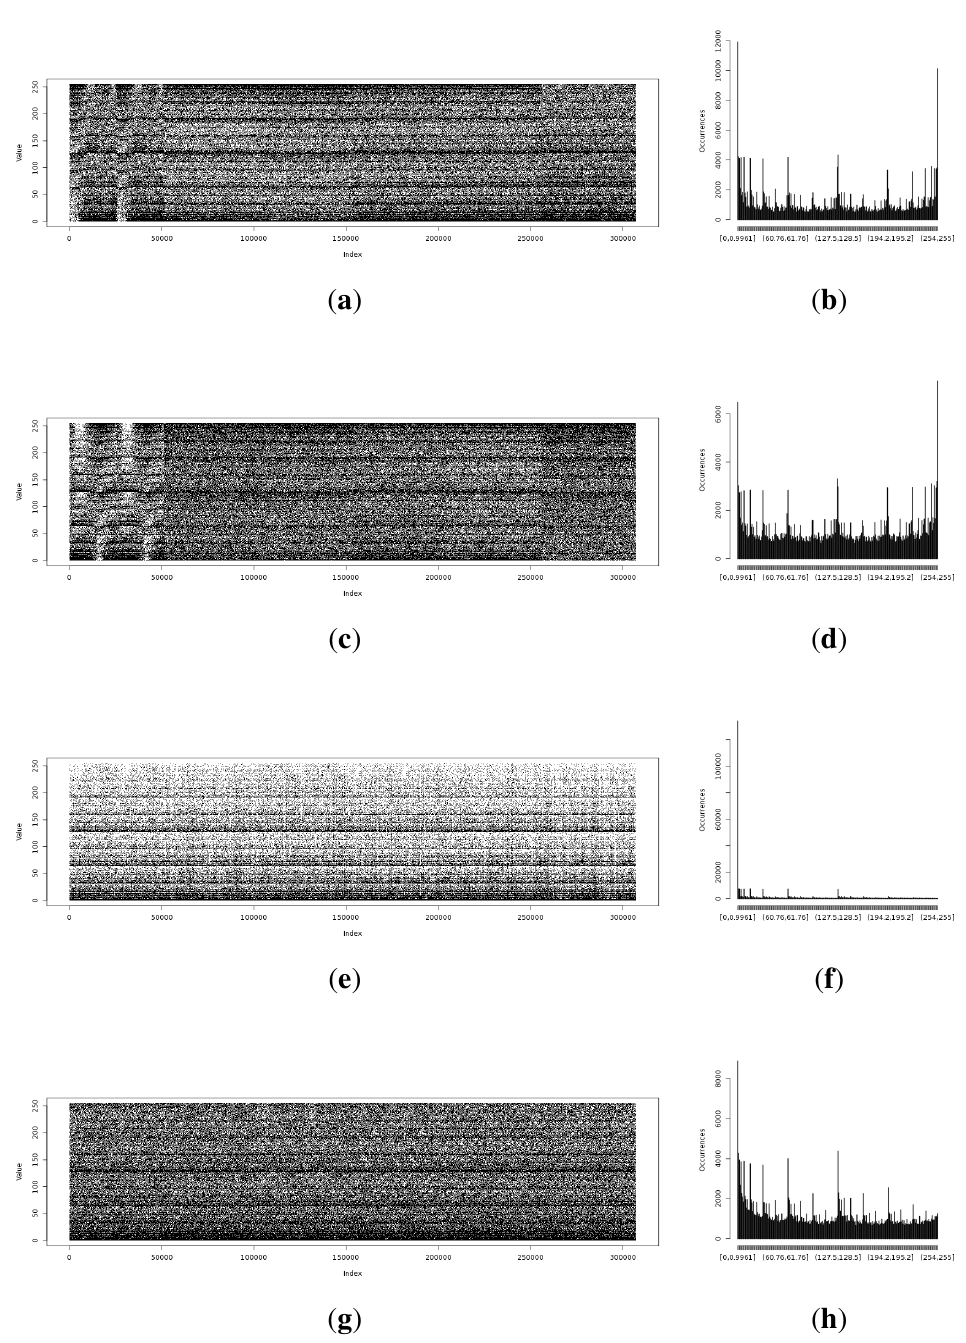
Figure 9. Entropy harvested by the first method from the particular on-board sensor. ( a ) Representation of the harvested entropy collected from the Light (1) sensor; ( b ) occurrence distribution for the Light (1) sensor; ( c ) representation of the harvested entropy collected from the Light (2) sensor; ( d ) occurrence distribution for the Light (2) sensor; ( e ) representation of the harvested entropy collected from the humidity sensor; ( f ) occurrence distribution for the humidity sensor; ( g ) representation of the harvested entropy collected from the temperature sensor; ( h ) occurrence distribution for the temperature